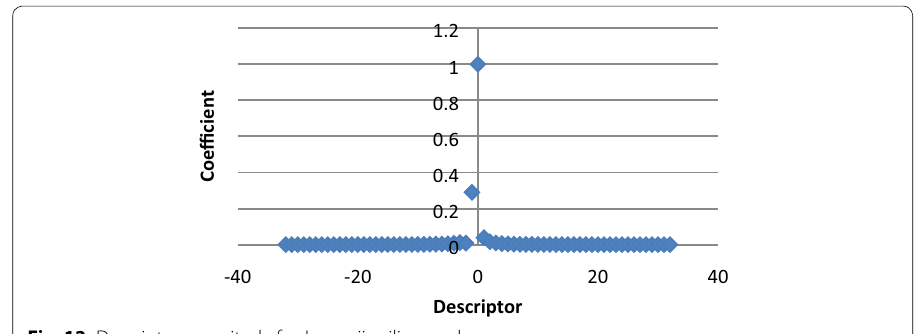
Fig. 12 Descriptor magnitude for Jumunjin silica sand